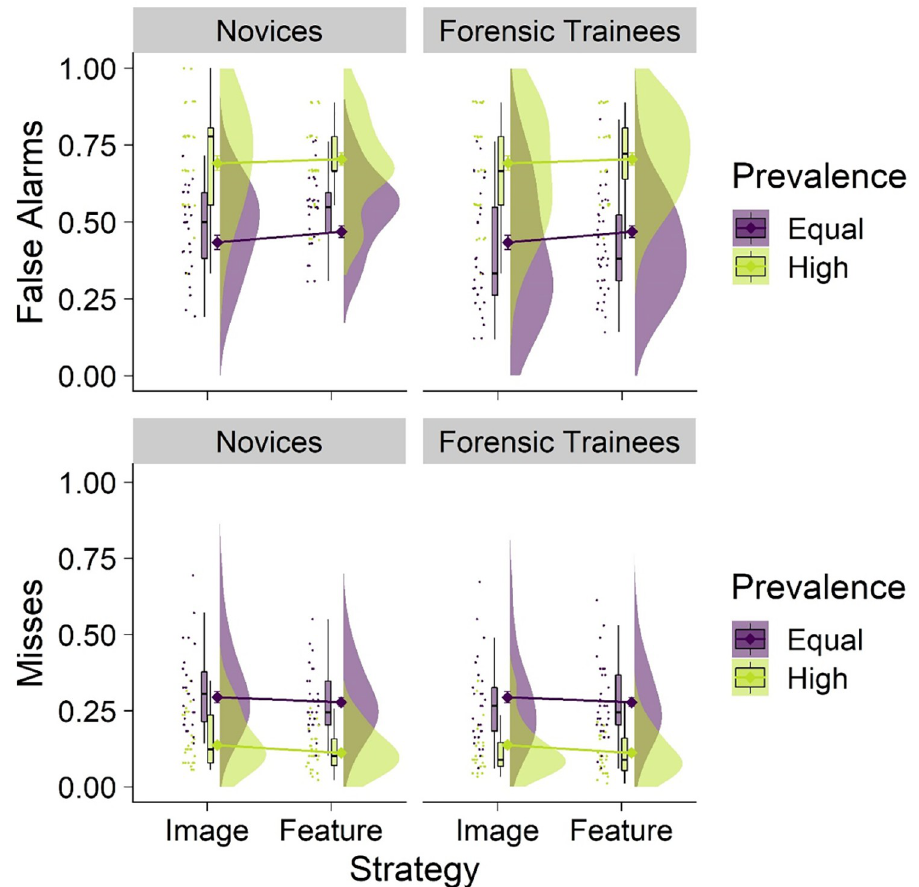
Fig 3. False alarms (top panel) and misses (bottom panel) by prevalence, strategy conditions, and group. Raincloud plots depict (left-to-right) raw jittered data points, box-and-whisker plots, means (represented by diamonds) with error bars representing ± 1 SE , and frequency